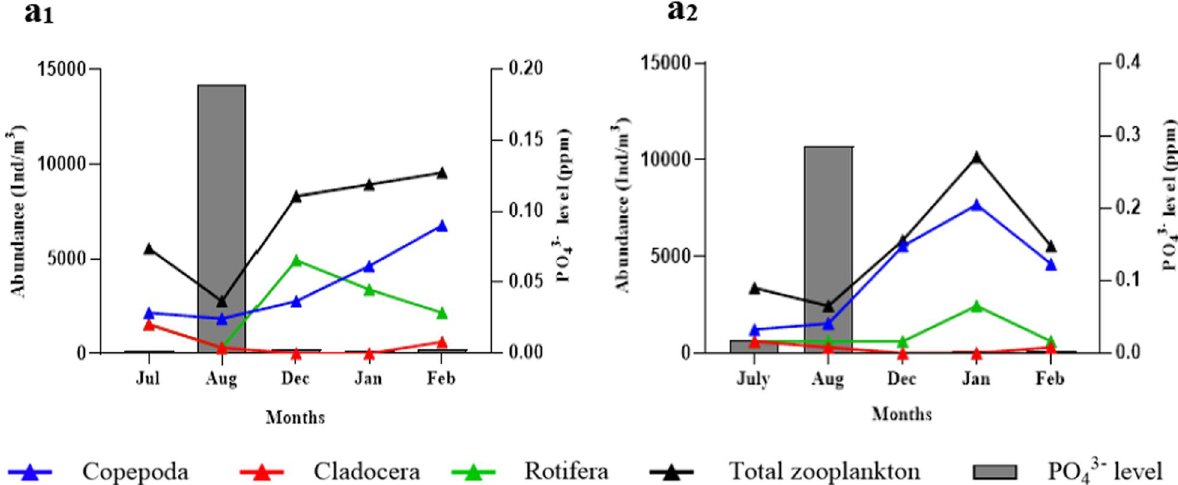
Fig. 8 Zooplankton abundance fluctuation with PO 3 − 4 level during July 2018–February 2019. a1 Vavuniya reservoir. a2 Thandikulam reservoir